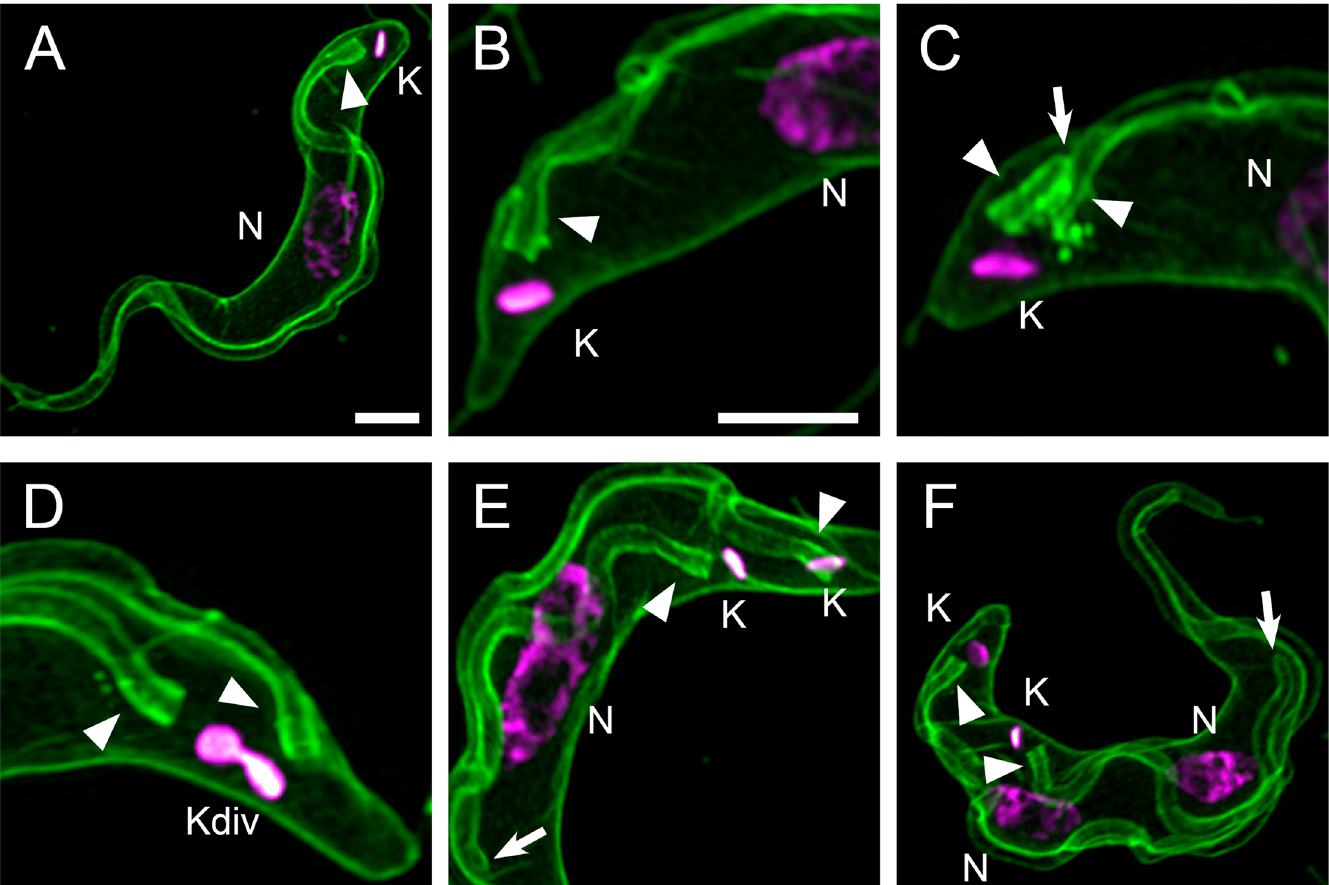
Fig 1. mCLING labels the plasma and flagellar membranes. Trypanosomes were incubated with mCLING-488 for 15 min on ice, fixed, and the kinetoplast (K) and nuclear (N) DNA was stained with DAPI. Panels presented are maximum intensity projections of 3D SR-SIM images. The “magenta hot” look-up table in Fiji (that colors areas of intense signal white) was applied to the DAPI channel. (A) Plasma and flagellar membrane staining of a whole trypanosome. (B) Plasma and flagellar membranes of a 1K1N trypanosome. (C) Plasma and flagellar membranes of a trypanosome that has two flagella, labeled with arrowheads. (D) Further growth of a nascent flagellum and apparent division of an elongated kinetoplast (Ke). (E) Elongation of the nucleus (compare to panel A) during mitosis, following kinetoplast division. Arrow points to the anterior tip of a growing flagellum. (F) Post-mitotic cell with two kinetoplasts and two nuclei. Arrow points to the tip of a growing flagellum. Arrowheads indicate the posterior bases of flagella. K = kinetoplast. Kdiv = dividing kinetoplast. N = nucleus. Scale bar = 2 μ m.